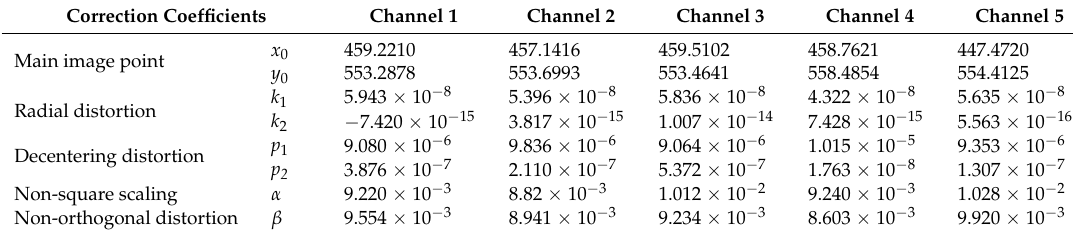
Table 3. The lens distortion correction coefficients for the Mini-MCA6.